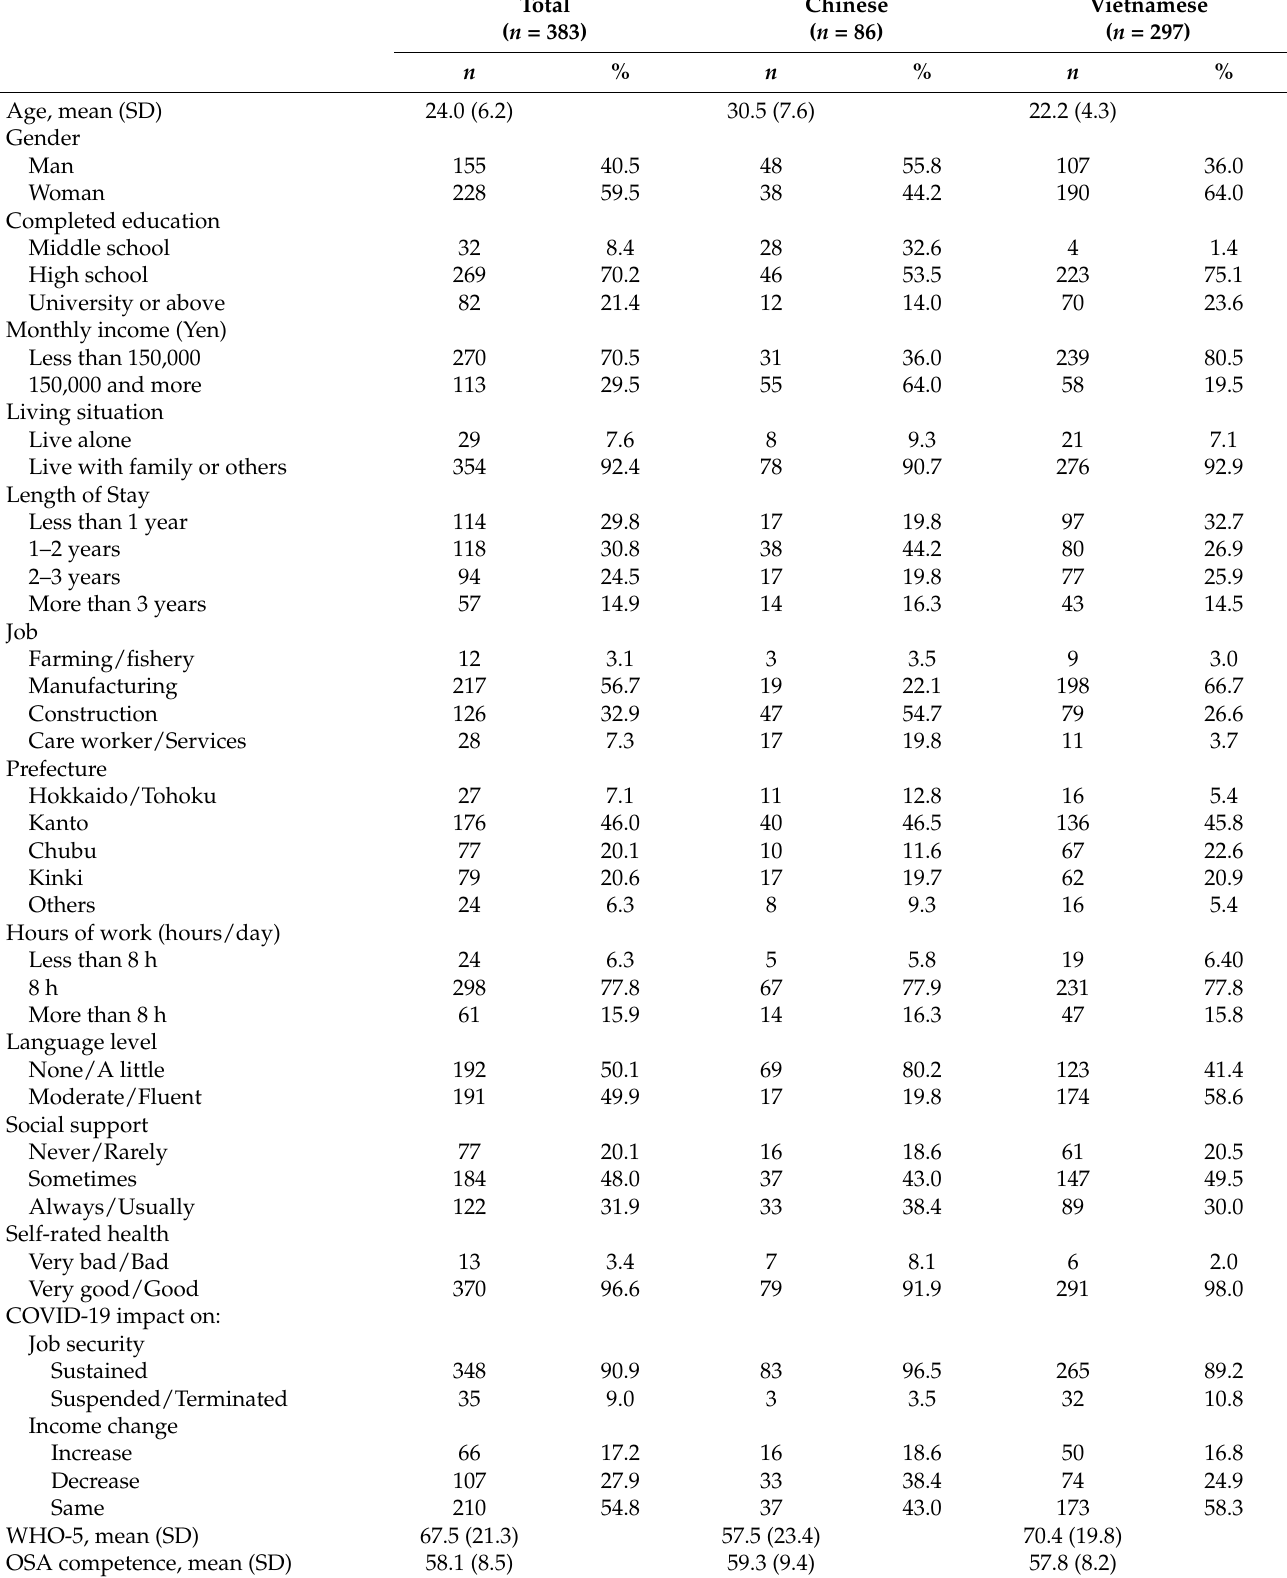
Table 1. Characteristics of technical intern